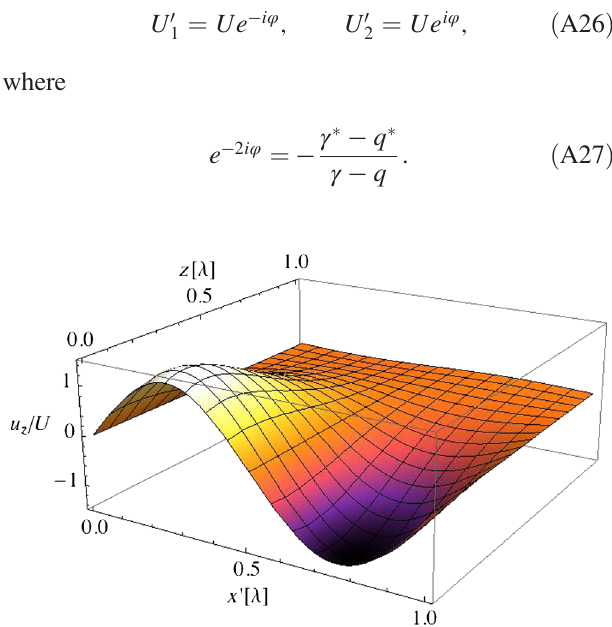
FIG. 6. Depth dependence of the (normalized) vertical dis- =U along ˆ x 0 ∥ ½ 110 (cid:2) for a Rayleigh surface acoustic placement u z wave propagating on a (001) GaAs crystal. The acoustic amplitude decays away from the surface into the bulk on a characteristic length scale approximately given by the SAW wavelength λ ¼ 2 π =k ≈ 1 μ